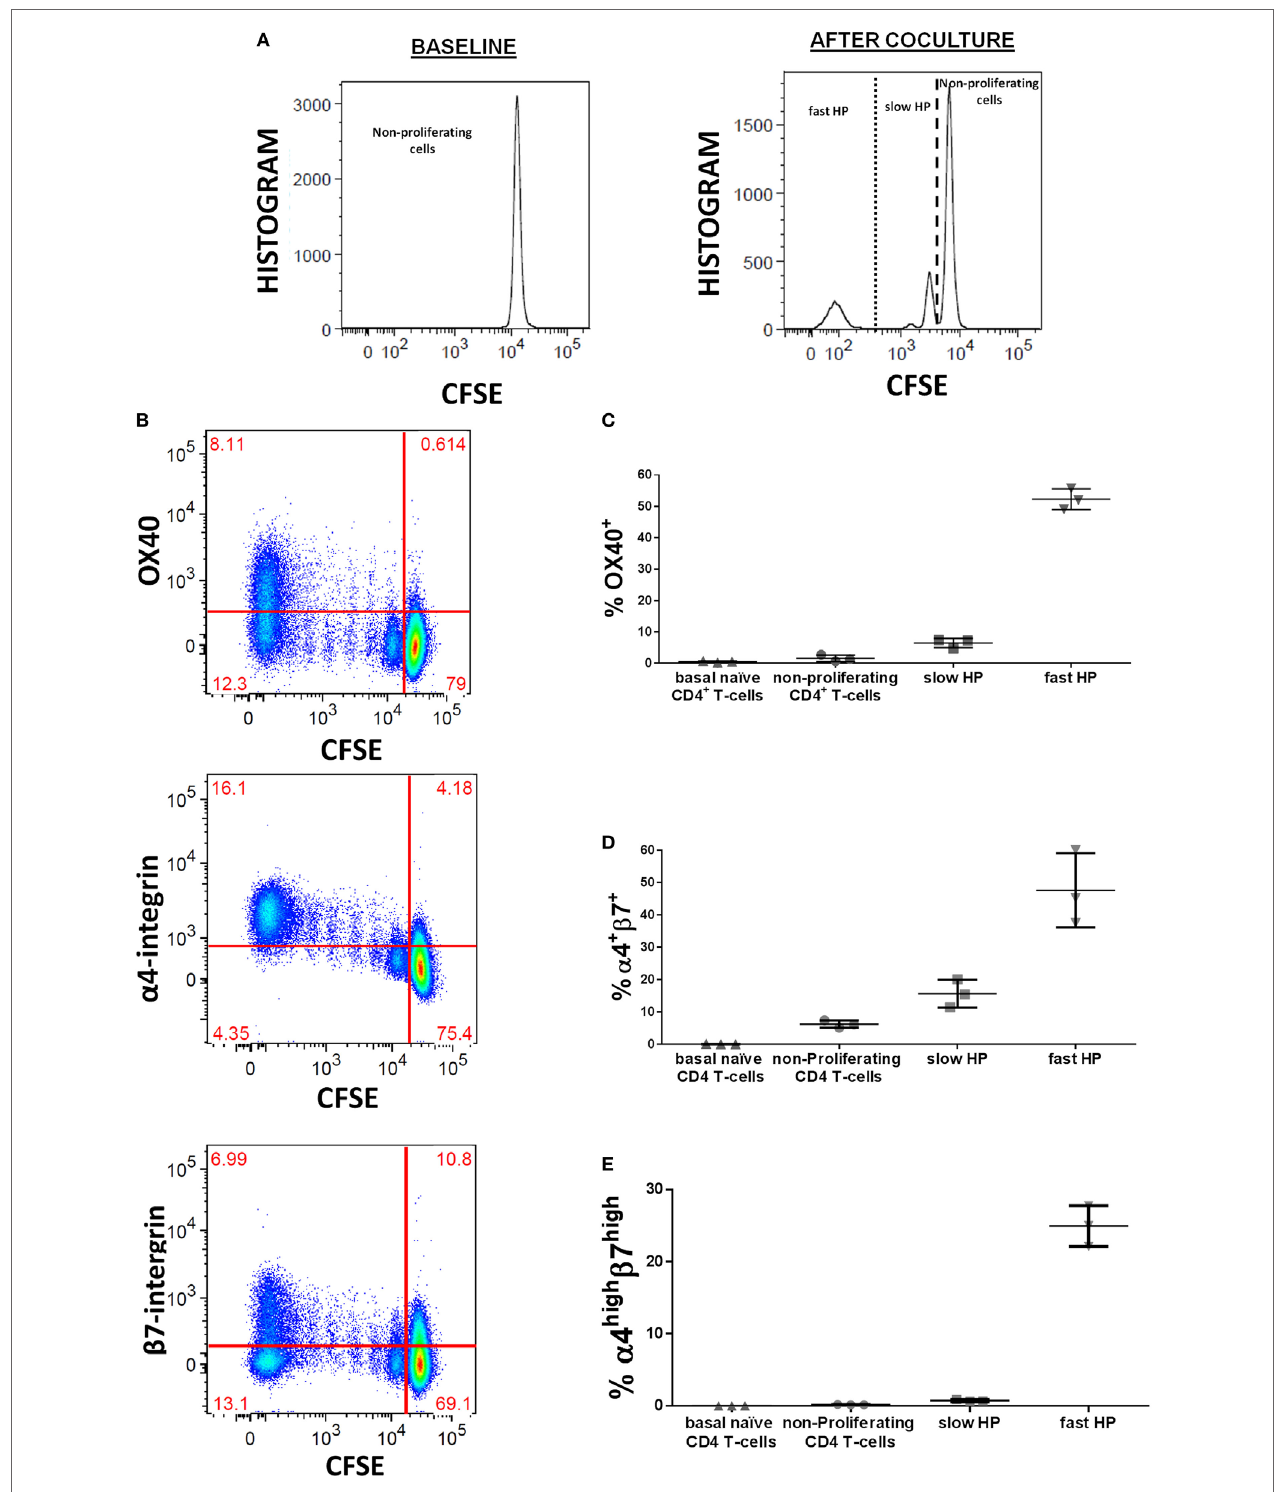
FigUre 2 | OX40 and α 4 β 7 expression during the homeostatic proliferation (HP) process of human naïve CD4 T-cells. Untouched CFSE-stained naïve CD4 T-cells were culture in presence of rIL7 (10 ng/ml) and with irradiated autologous APCs (1/1 ratio): (a) representative CFSE histograms used for identification of different types of HP at baseline (0 day) and after 10 days of culture, (B) OX40, α 4-integrin, and β 7-integrin upregulation during HP, (c) frequencies of OX40 in the different types of HP subsets, (D) frequencies of α 4 + β 7 + in the different types of HP subsets, (e) frequencies of α 4 high β 7 high in the different types of HP subsets. Frequencies of both OX40 and α 4 β 7 were calculated after background substation from baseline condition. Data are expressed as mean value and